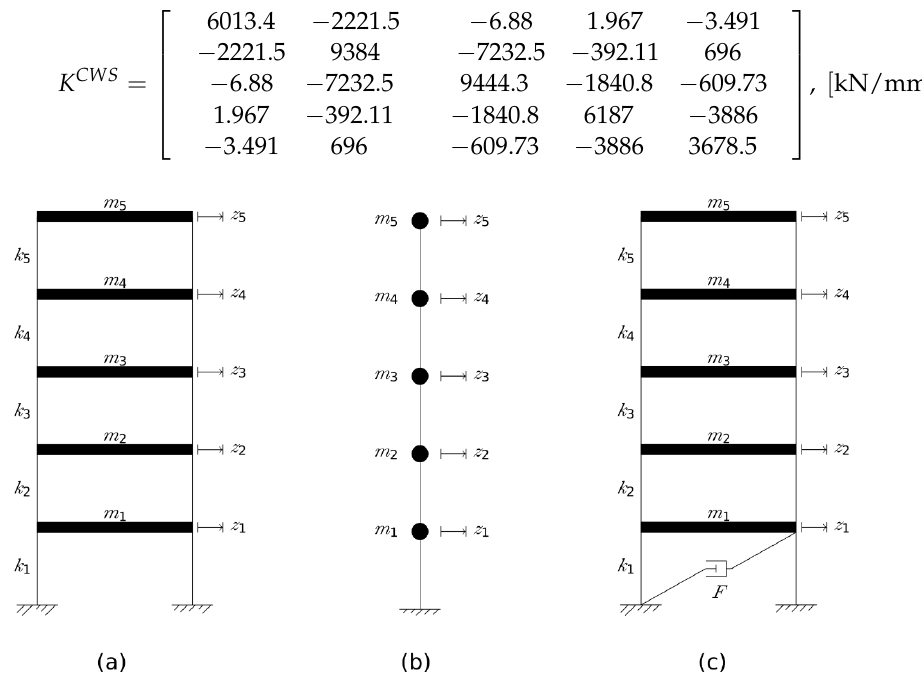
Figure 4. Dynamic schemes used for seismic response simulation of ( a ) the control case, ( b ) Cases 1 and 2, and ( c ) Cases 3 and 4. Table 5. Mass values used in the dynamic models of each of the cases.